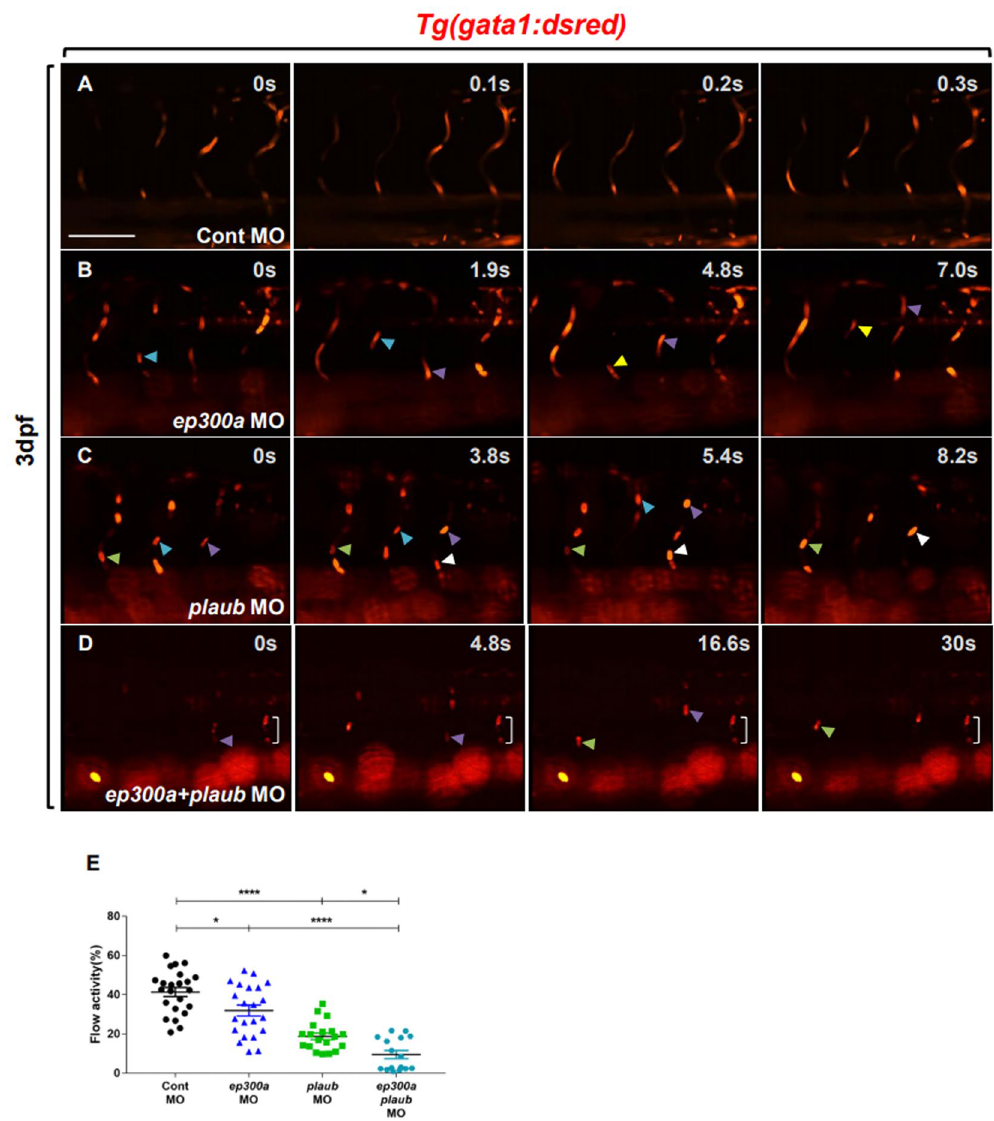
Figure 7. Knockdown of ep300a and plaub caused the vascular occlusion phenotype in zebrafish. Lateral views of the trunk of Tg ( gata1:dsred ) zebrafish larvae (dorsal or ‘to the top’ and anterior or ‘to the left’) at 3 days post-fertilization (dpf) ( A – D ). Arrowheads indicate the slowly circulating red blood cells (RBCs) in the intersegmental vessels (ISVs). The bracketed area indicates stalled RBCs in the ISVs. Analysis of RBC circulation ( E ) in the control, ep300a , and plaub morpholino (MO)-injected larvae at 3 dpf (Control MO: 41.39 ± 2.39 (n = 23), ep300a MO: 31.97 ± 2.78 (n = 22), plaub MO: 18.79 ± 1.68 (n = 19), ep300a / plaub MO: 9.50 ± 2.01 (n = 16); * p < 0.05, **** p < 0.0001; scale bar = 100